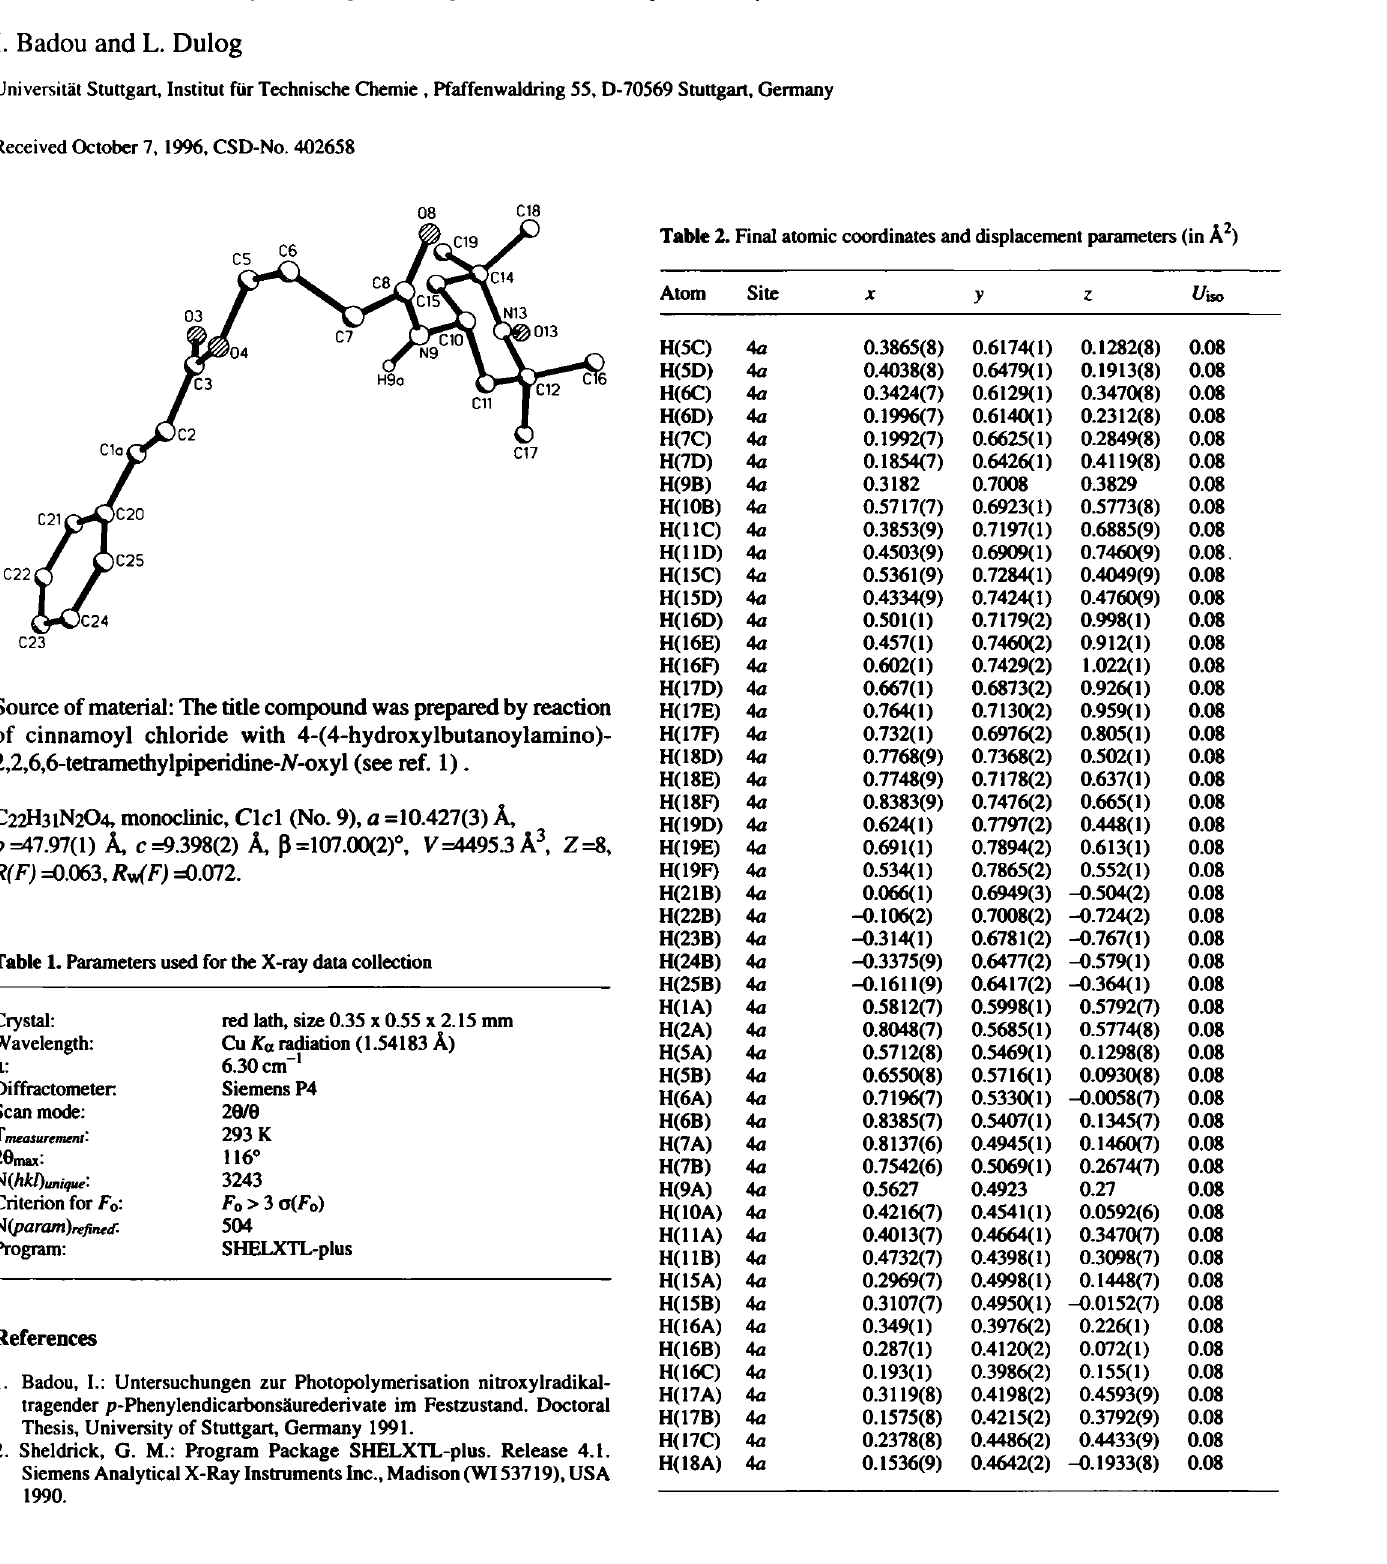
Table 2. Final atomic coordinates and displacement parameters (in Â 2 )